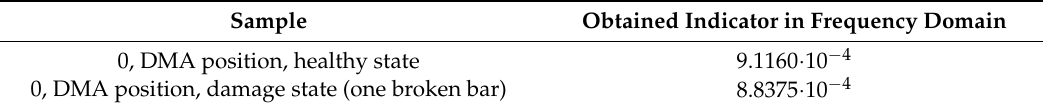
Figure 2. Comparison of the frequency spectra of the flux signals for the healthy state (blue) and for the faulty state with one broken bar (red). Sample 0, DMA position. Table 5. Obtained results by applying the one-dimensional Fourier Transform and calculating the indicator (Equations (4) and